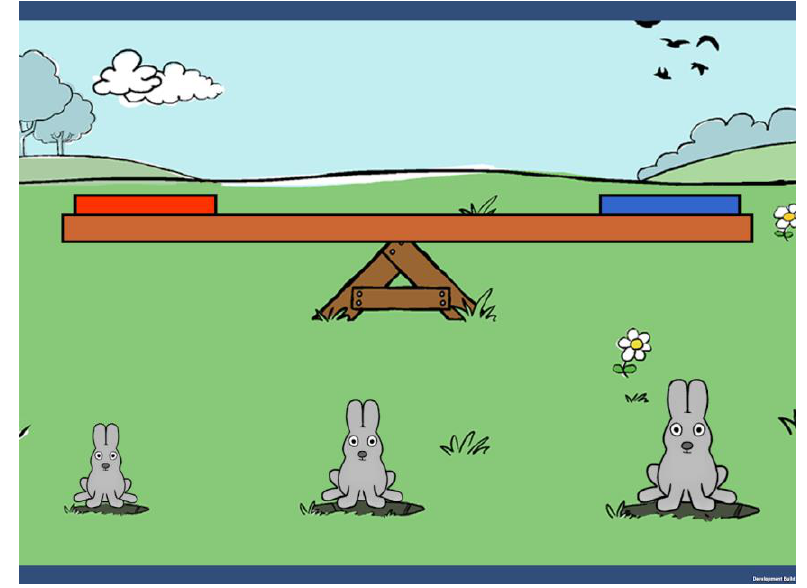
Figure 1. Screenshot of Peep and the Big Wide World -Based Bunny Balance.